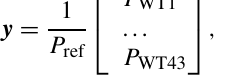
Figure 15. Relative increase in the optimization cost function for the Sedini wind farm when eliminating one parameter set at a